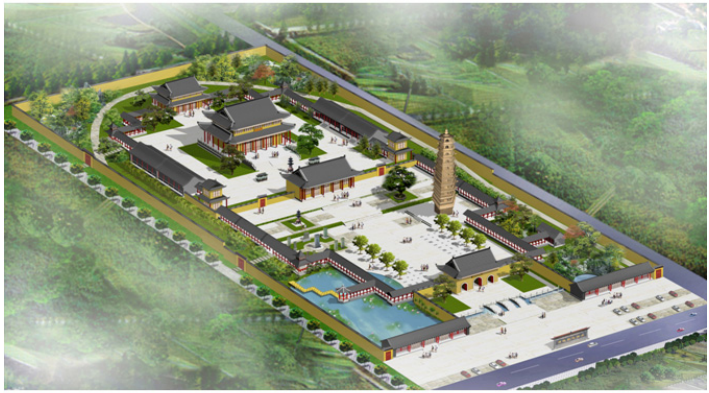
Figure 2. Gao Tang. Aerial of Gaotang Xingguo Temple and view. Location map.